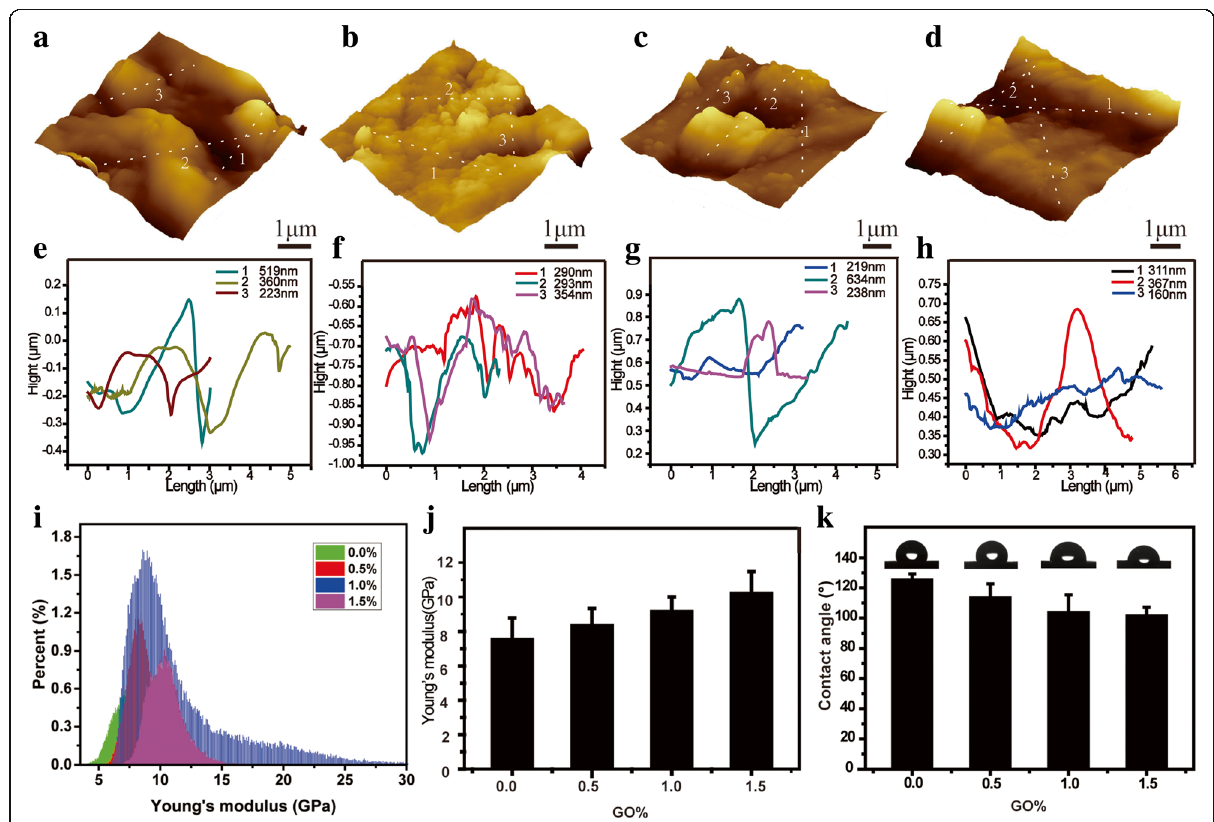
Fig. 4 AFM images of a nHAC/PLGA, b nHAC/PLGA/GO (0.5 wt%), c nHAC/PLGA/GO (1.0 wt%), and d nHAC/PLGA/GO (1.5 wt%) scaffolds. e – h Line profiles derived from the morphology images. i Stiffness distribution of the four different scaffolds measured by QNM-AFM. j The bar chart of Young ’ s modulus versus the GO amount. k The corresponding contact angles of four kinds of scaffolds measured by the sessile drop